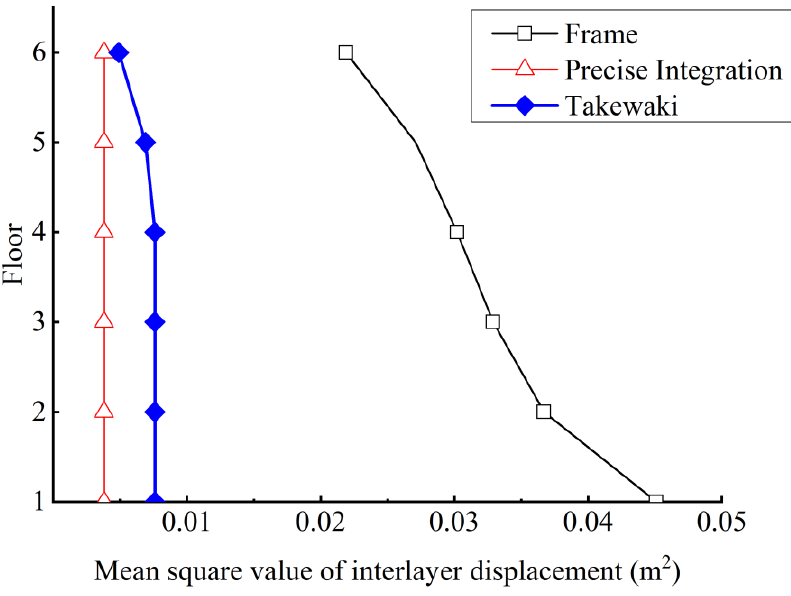
Figure 6. Six-story shear frame: mean squared interstory drifts before and after optimization